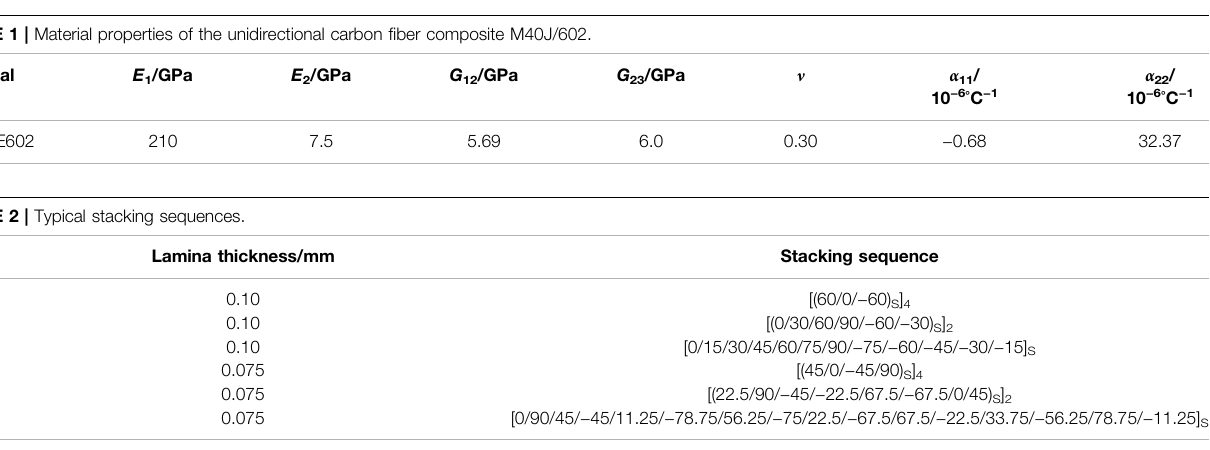
Frontiers in Mechanical Engineering |